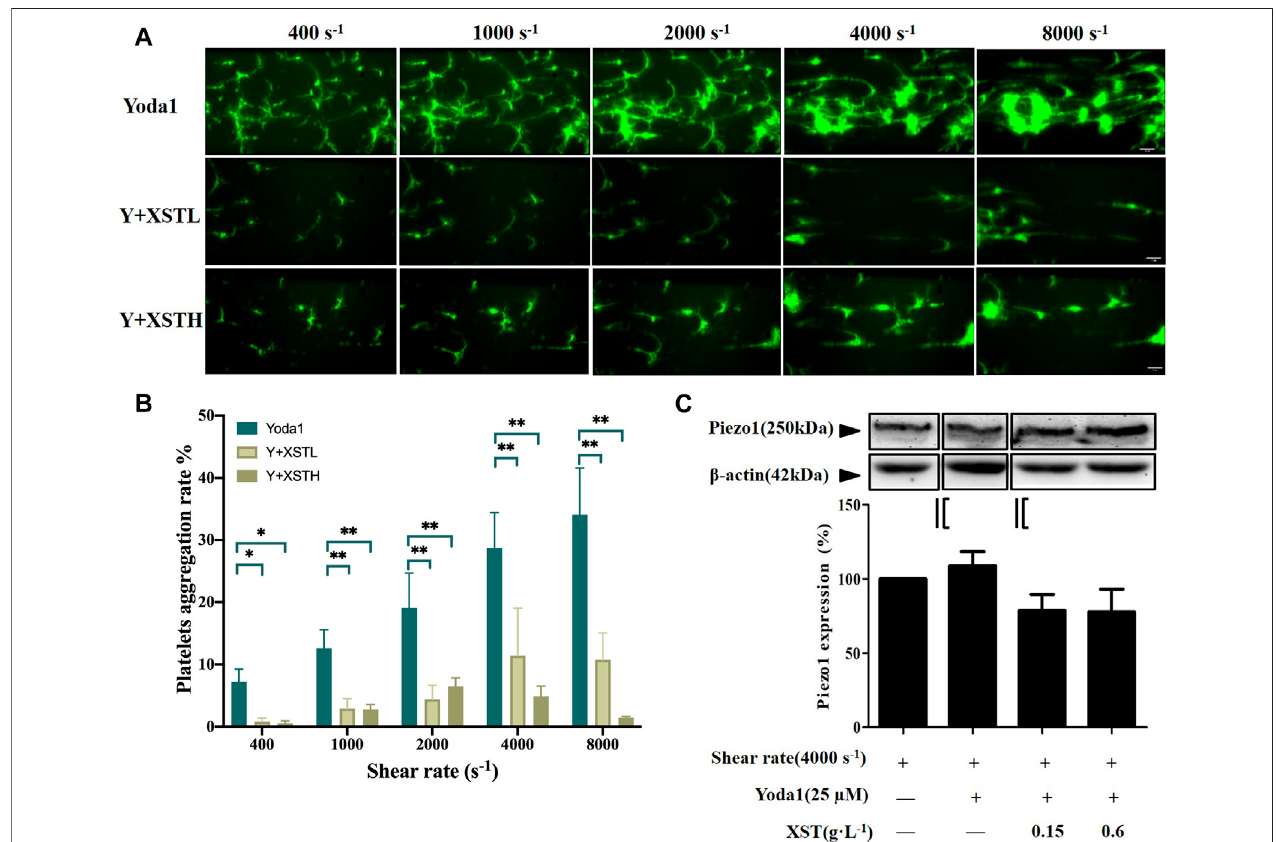
FIGURE 4 | Effects of XST on platelet aggregation induced by shear stress and Yoda1. (A) Representative images showing the effects of treatment with Yoda1 (25 µM) alone or together with XST at 0.15 g L − 1 (XSTL) or 0.6 g L − 1 (XSTH) on shear-induced platelet aggregation. The scale bar 50 µm. (B) Mean platelet aggregation rate at the end of exposure to indicated shear rates. # p < 0.05 and ## p < 0.01, analyzed by two-way ANOVA and post-hoc Tukey ’ s test. (C) Western blotting analysis of the Piezo1 expression in platelets under shear rate of 4,000 s − 1 and exposure to Yoda1 (25 μ M) alone or Yoda one together with XST, and the grouping was highlighted by black lines. Although shear induced platelets aggregation was enhanced by Yoda1, however, exposure to Yoda1 alone, or Yoda1 together with XST resulted in no signi fi cant effect on the Piezo1 expression. Top: representative blots; bottom: mean data from three independent experiments.